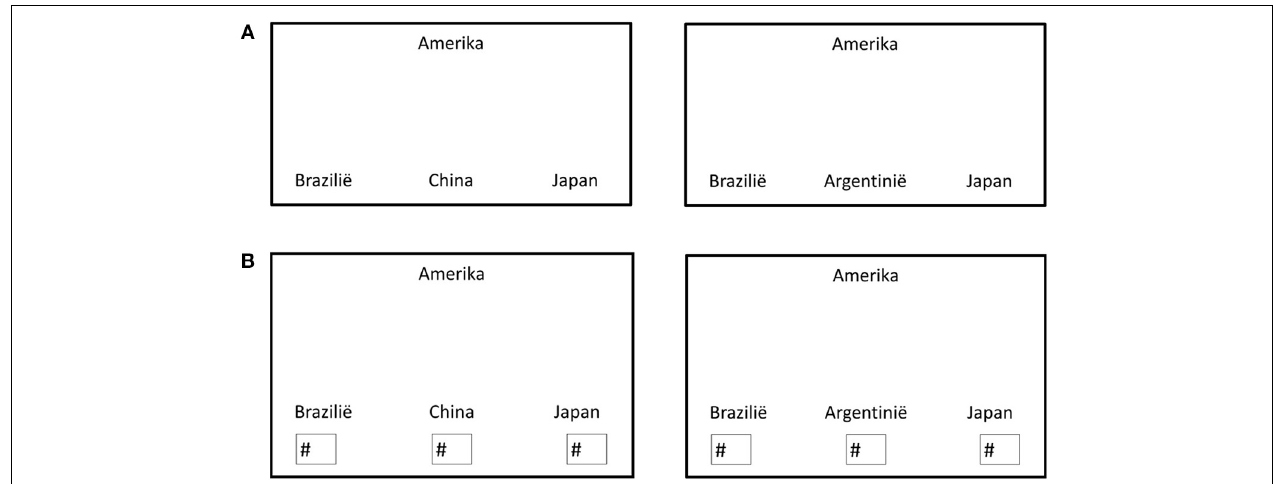
FIGURE 5 | (A) Example of a similarity-judgment trial completed by the Dutch participants in condition 1 (left) and condition 2 (right). (B) Example of a ranking trial completed by Dutch participants in condition 1 (left) and condition 2 (right).